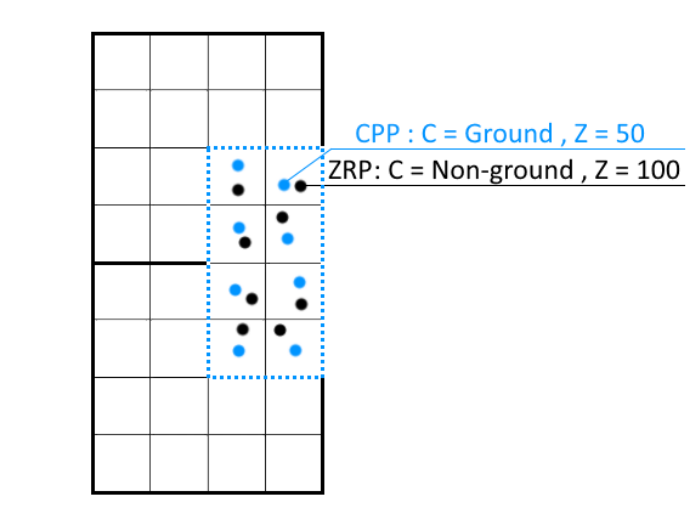
Figure 4. Schematic example of a classification error correction. The zone-raster-point (ZRP) has been misclassified as non-ground, and must be entirely replaced by the correction-patch-point (CPP) as the ZRP has a higher Z value.